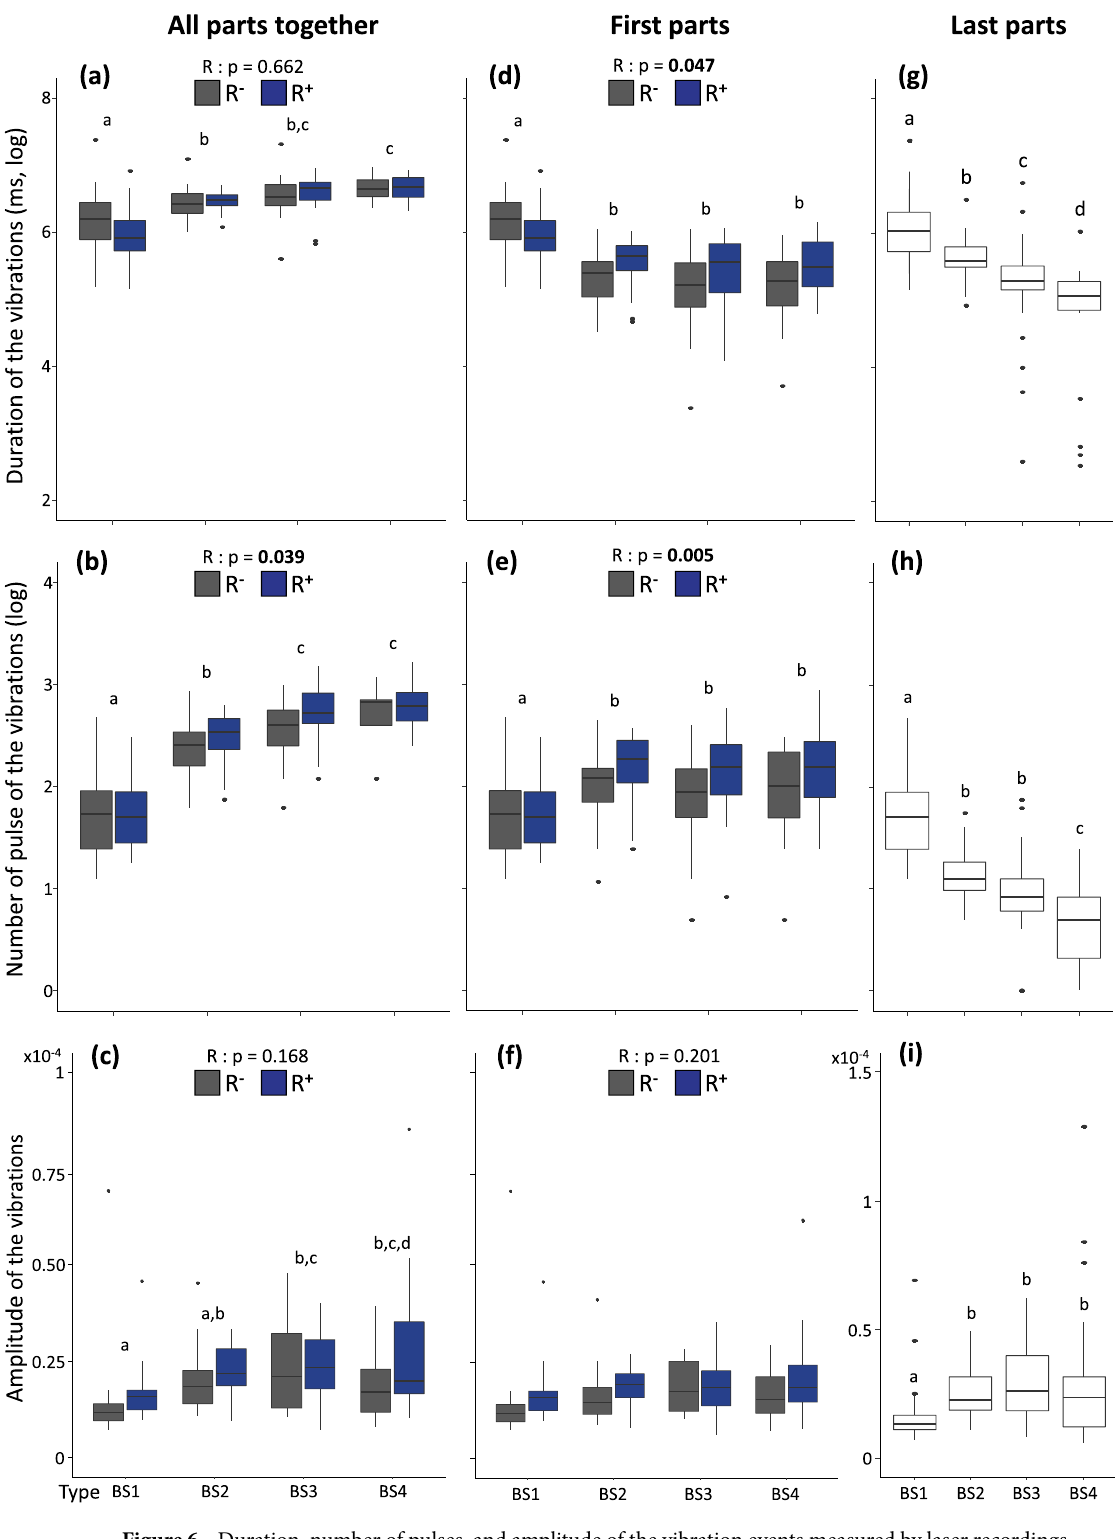
Figure 6. Duration, number of pulses, and amplitude of the vibration events measured by laser recordings. The different types of body-shaking (BS1-4) are represented, in absence of reproductives (R − , grey boxes) or in presence of reproductives (R + , blue boxes). The p values of the reproductive effects are indicated in bold when significant. Data (R − and R + ) were pooled together (white boxes) when no reproductives effects were found. Note that for representation comparisons, some graphs have not been pooled. Different representations are shown: all parts pooled together i.e. the entire vibration events ( a – c ), the first parts only ( d – f ), and the last parts only ( g – i ) for each type of body-shaking (BS1-4). Within each graph, different letters represent significant differences between each type of body-shaking ( p < 0.05). Dots indicate